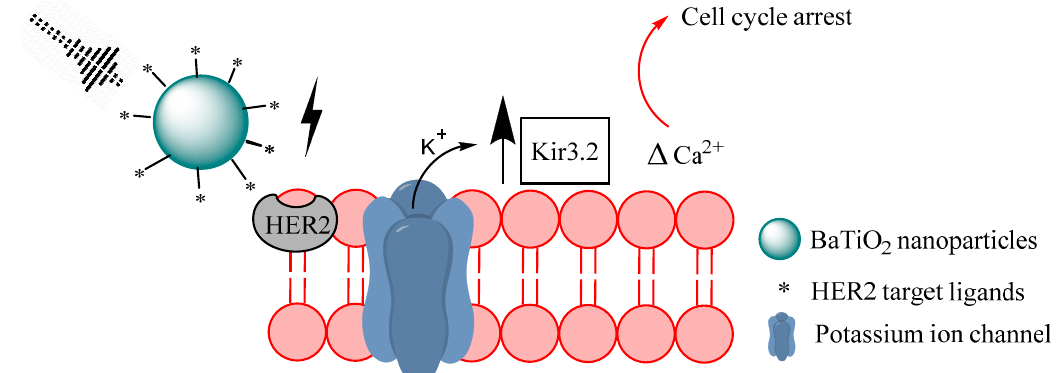
Figure 4. Graphic representation of ultrasound stimulated piezoelectric stimulation of breast cancer cells. Upon ultrasound induced deformation, barium titanate nanoparticles create a potential difference that interferes with Ca 2+ homeostasis and upregulates the Kir3.2 gene.